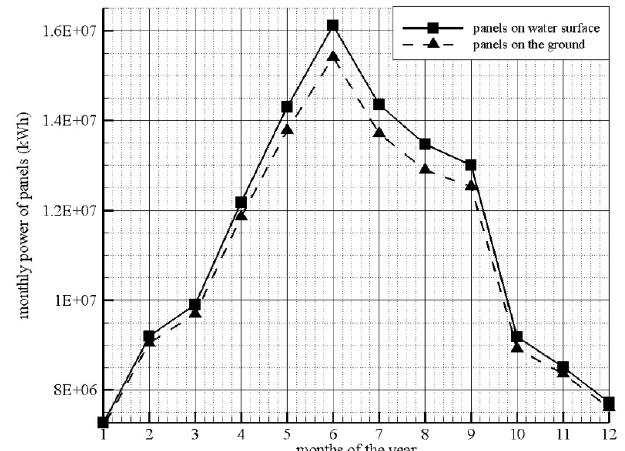
Figure 8. Monthly power generation of total panels on the water surface and on the